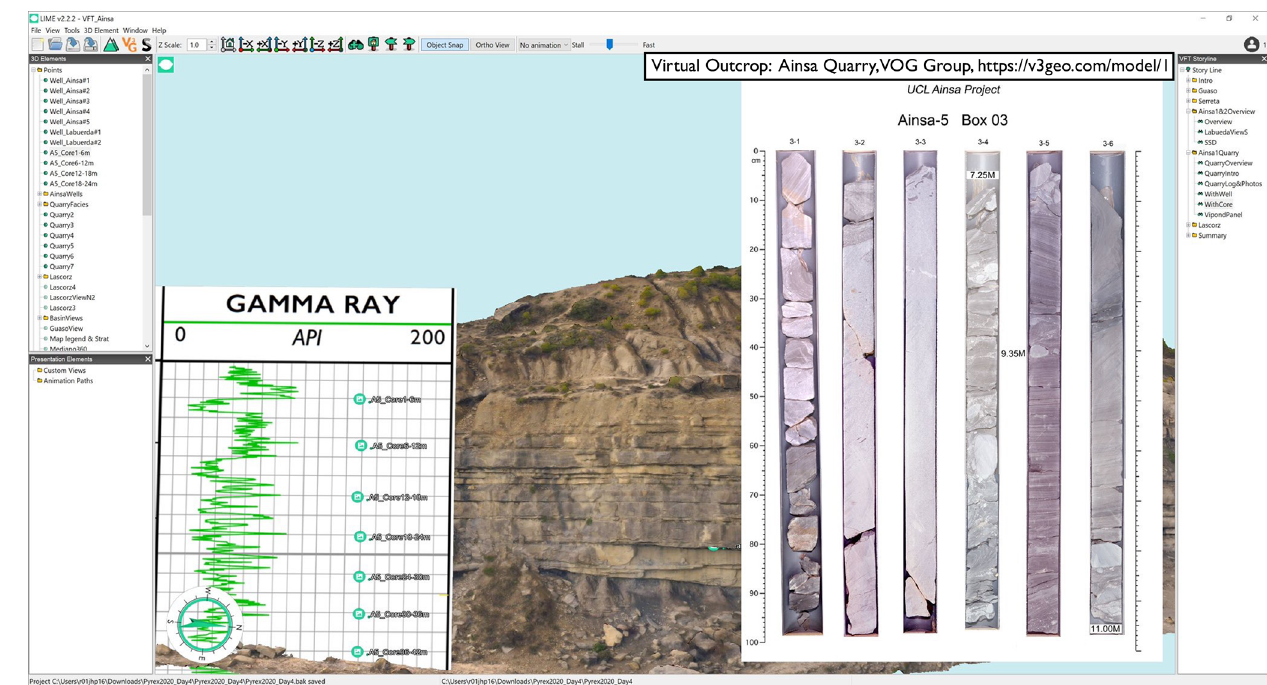
Figure 6. Ainsa Quarry, Spain, a view within the Pyrenees 2020 virtual field trip. Virtual outcrop data are available at the following: Ainsa Quarry, VOG Group, https://v3geo.com/model/1 (last access: 1 September 2021), supplemented with additional material including well logs and core photos within LIME. Core photos from Pickering and Corregidor